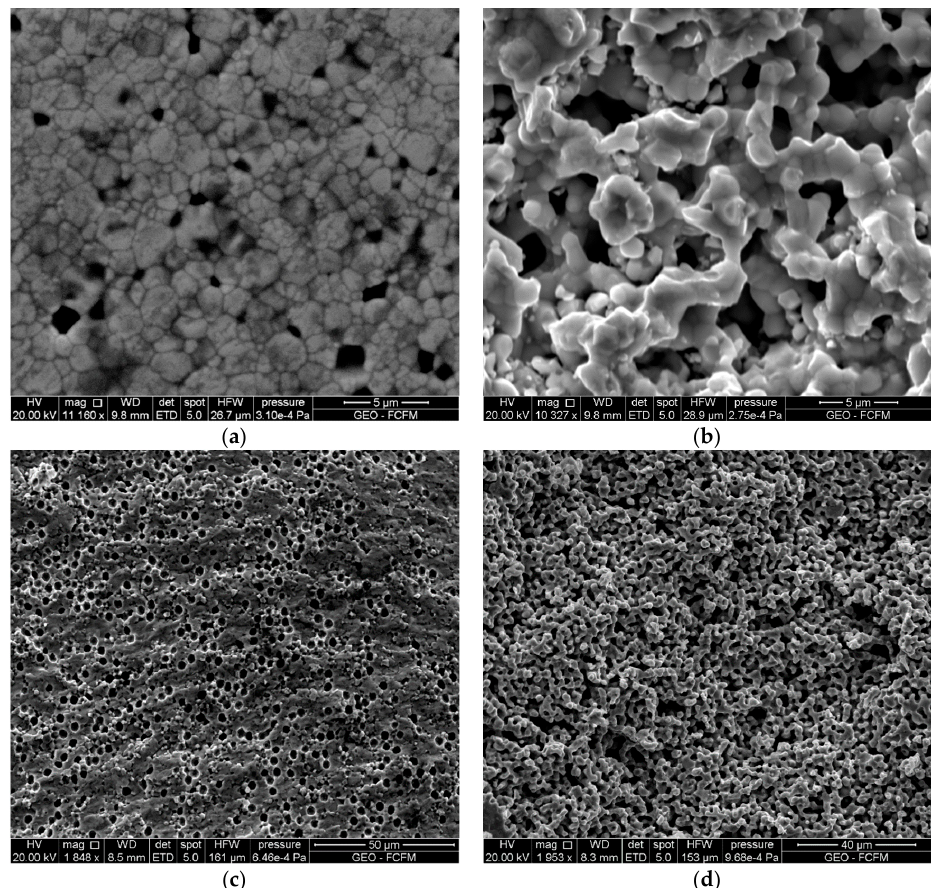
Figure 2. SEM images of surface of samples ( a ) LSCF-P5 and ( b ) LSCF-P20 after annealing and the fracture surface of samples ( c ) LSCF-P5 and ( d ) LSCF-P20.